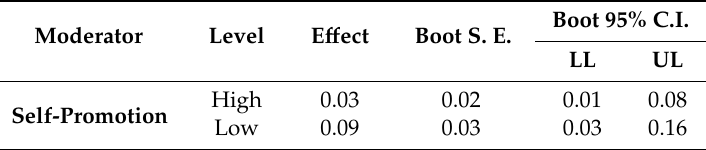
Table 6. Conditional indirect effects of TMS on CR via taking charge.